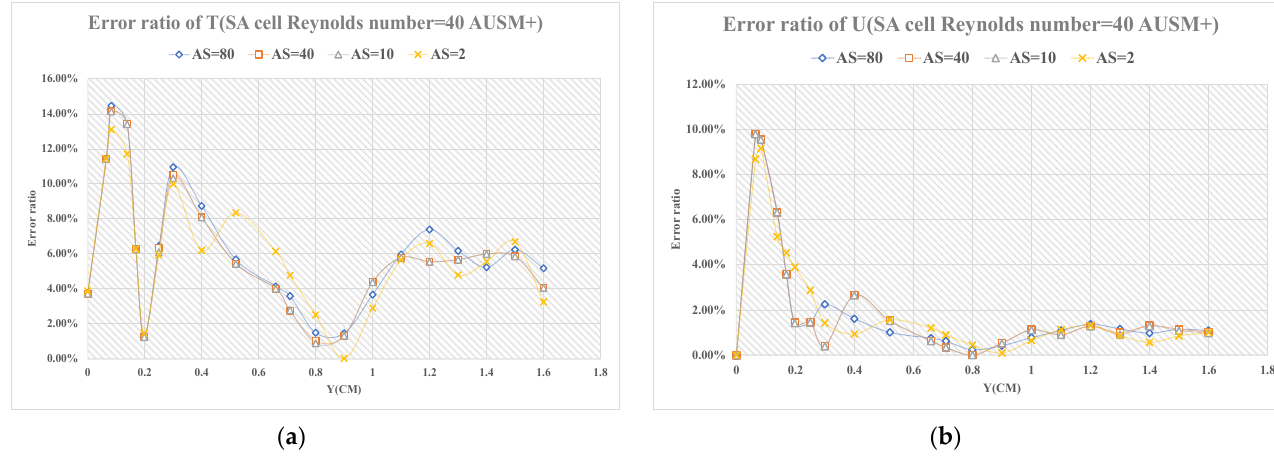
Figure 25. ( a ) error ratio distribution diagrams of T at S = 0.155 m; ( b ) error ratio distribution diagrams of U at S = 0.155 m.